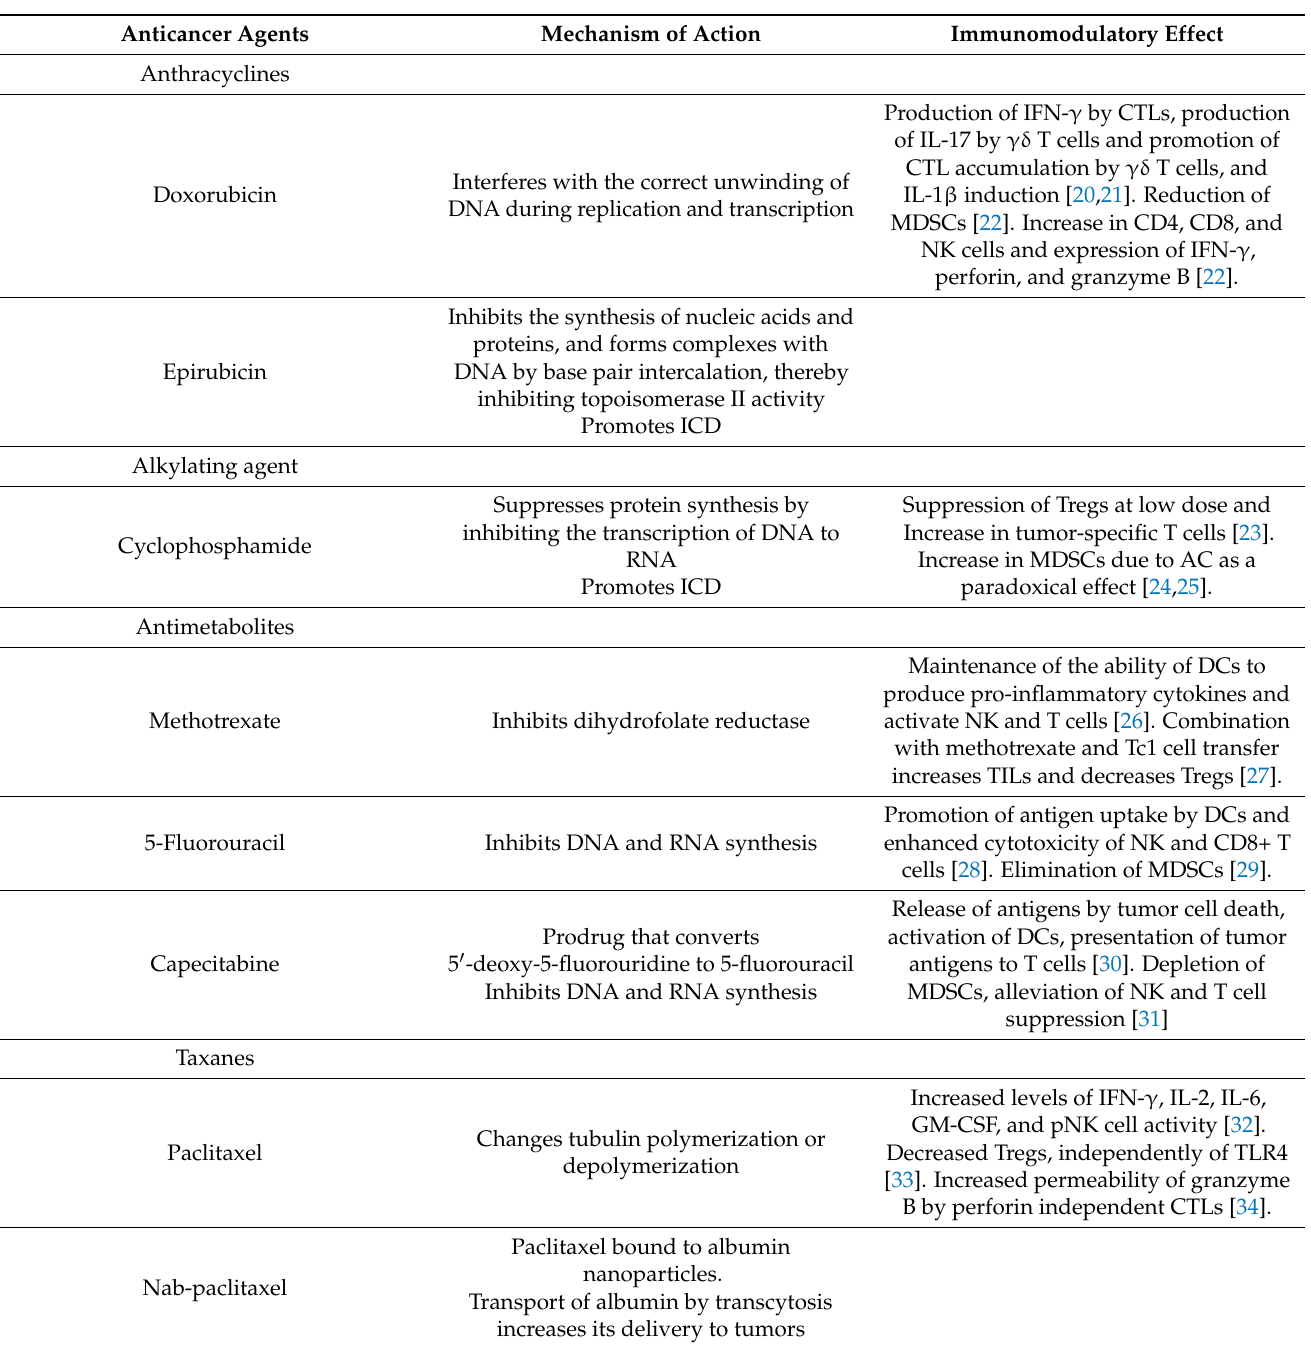
Table 1. Summary of the mechanistic actions and immunomodulatory effects of anticancer agents used for primary breast cancer